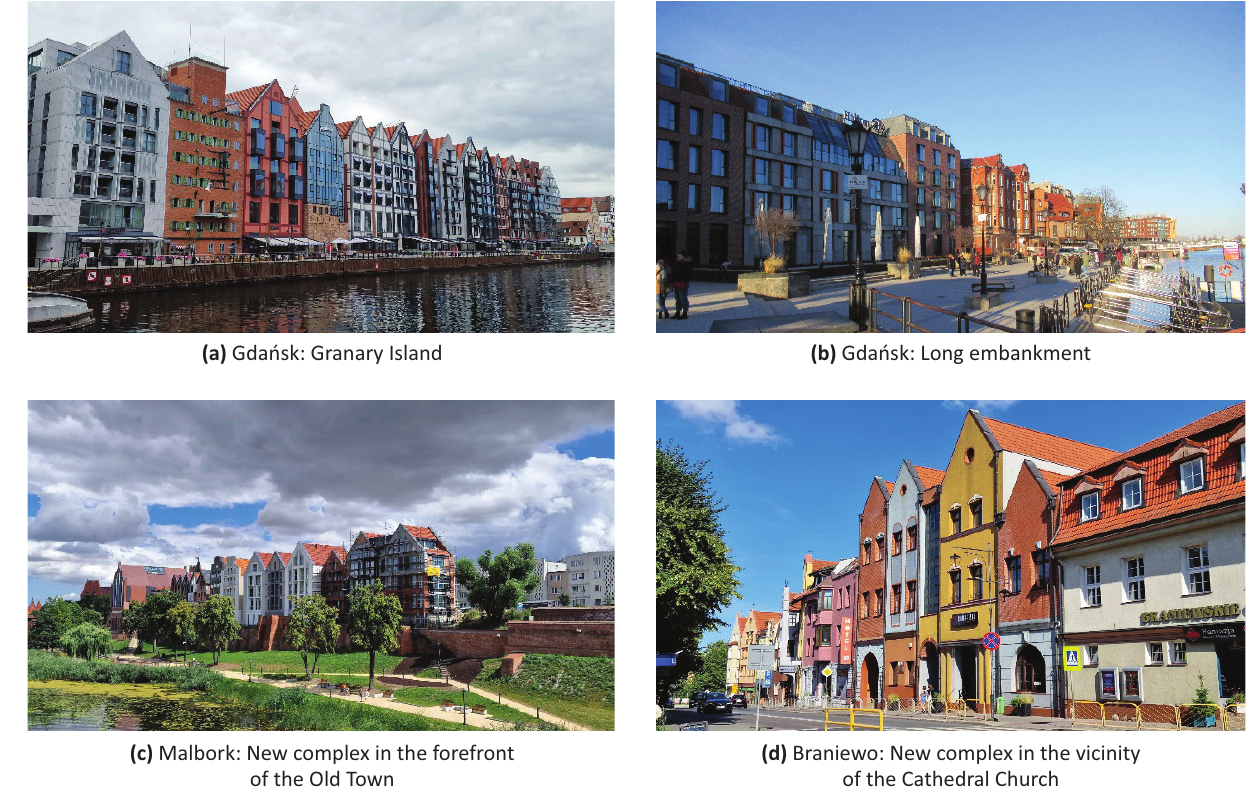
Figure 5. Selected examples of the structures rebuilt according to the concept of “theming.” Urban Planning, 2023, Volume 8, Issue 1, Pages